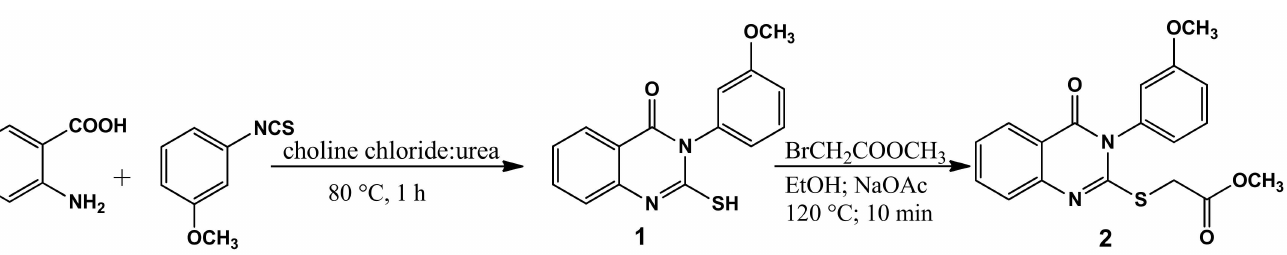
Figure 2. Synthetic path for